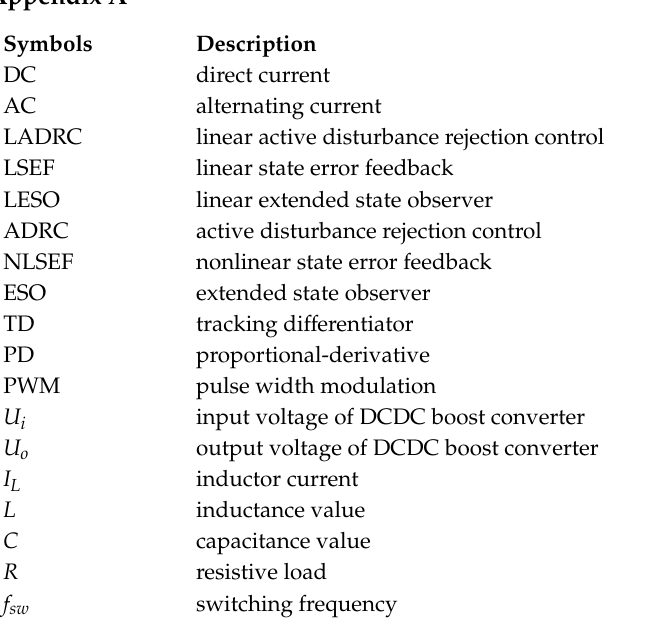
Figure 17. ( a ) LADRC controller: experimental comparison responses with Case 3; and ( b ) PI controller: experimental comparison responses with Case 3.